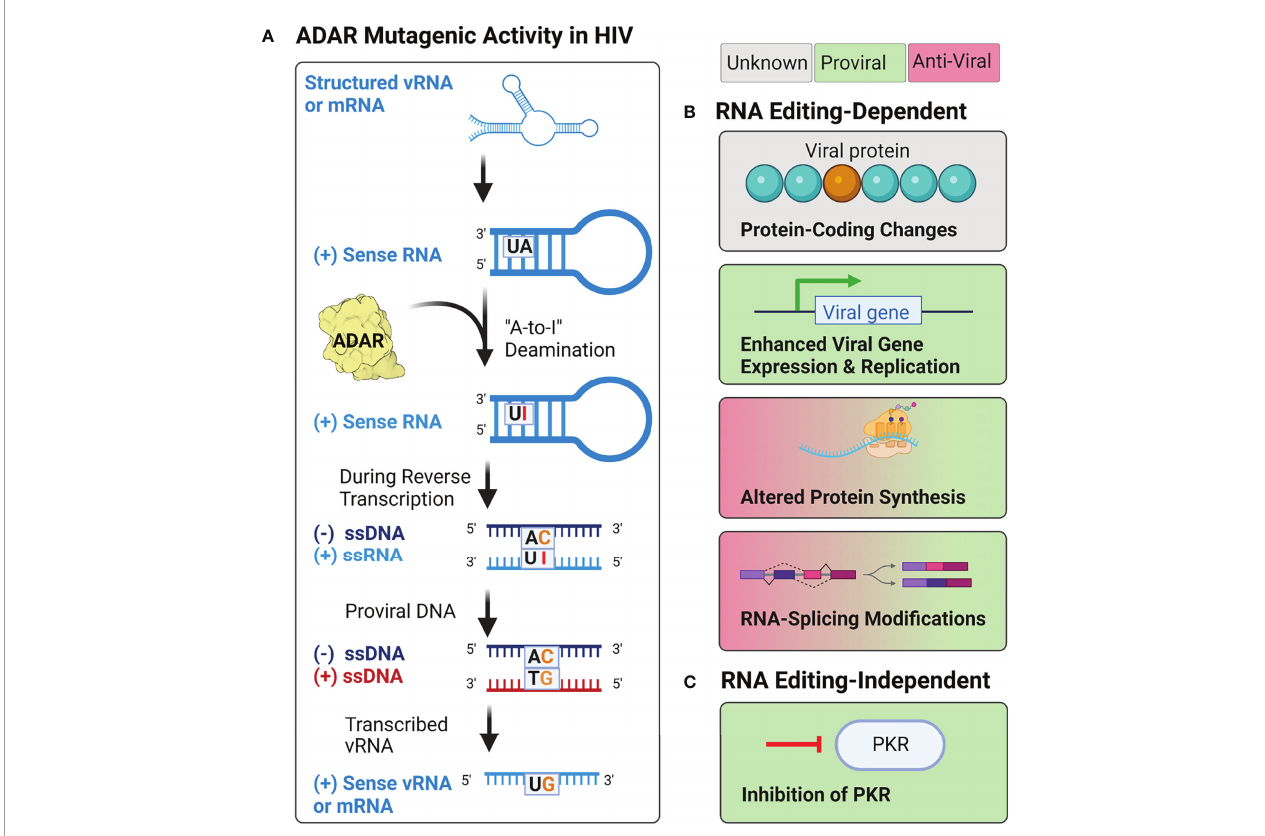
FIGURE 6 | Potential effects of ADAR activity during HIV-1, HIV-2, and HTLV-1 infection. (A) Adenosine deamination reactions by ADAR proteins during retroviral replication are thought to induce A-to-I mutations within structured RNA elements from both the incoming vRNA genome and transcribed mRNA products. When these mutations occur during reverse transcription, it may lead to the introduction of A-to-G mutations in the integrated provirus. (B) Proposed RNA editing- dependent enzymatic activities of ADAR during retroviral infection have reported pro- and antiviral effects on protein synthesis, viral gene expression and replication, rates of protein synthesis, and RNA-splicing. (C) Proposed RNA editing-independent effects include inhibition of